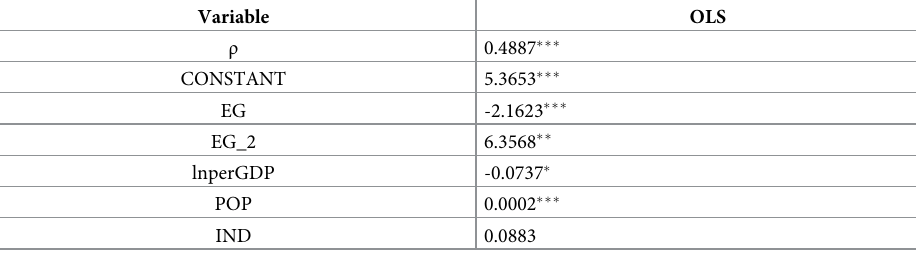
Table 11. SEM estimation of the impact of enterprise agglomeration on air